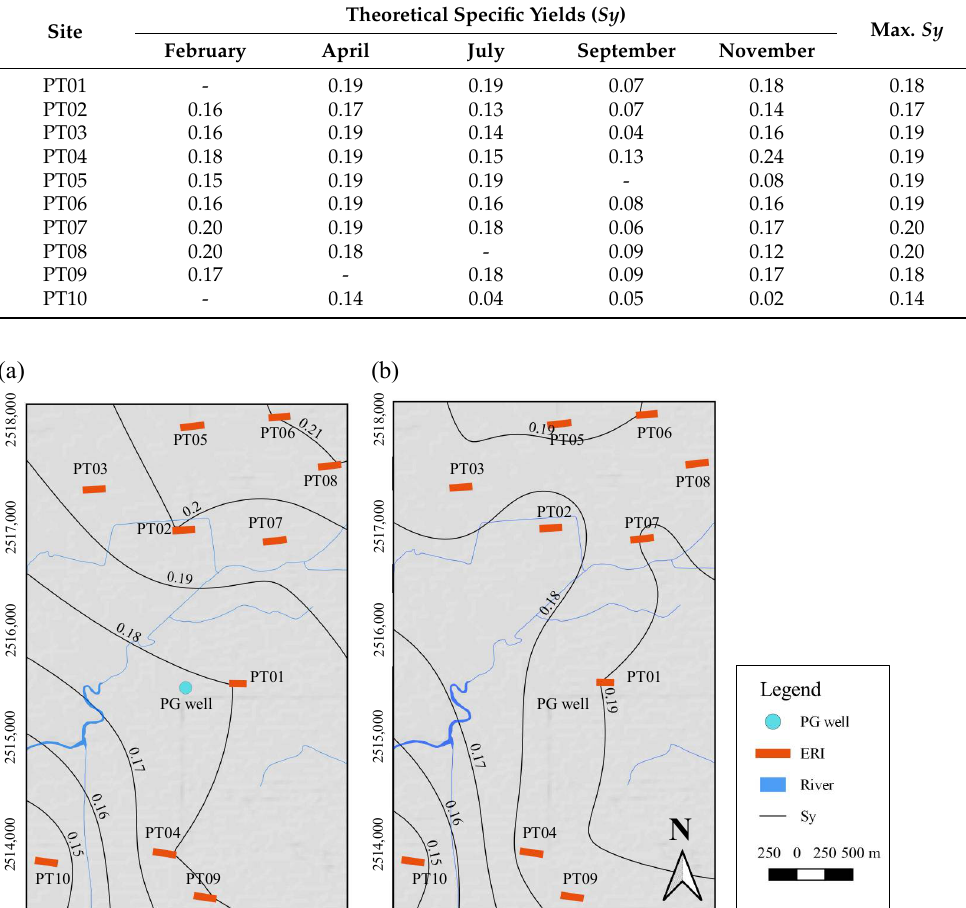
Table 6. The estimated theoretical specific yields ( Sy ) were calculated from Brooks–Corey for five different months of 2019.